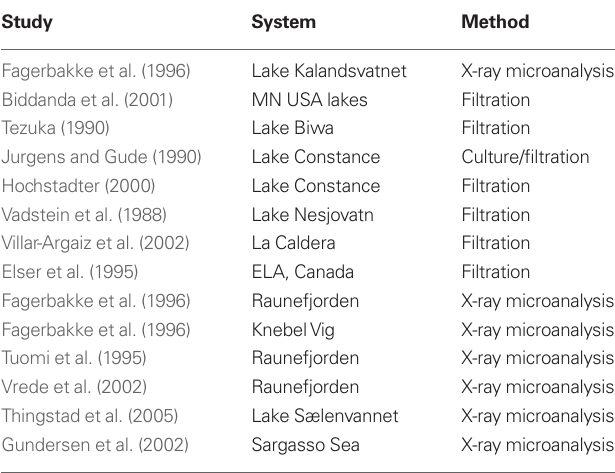
Table 3 | Studies from literature survey that collected field samples to estimate bacterial stoichiometry